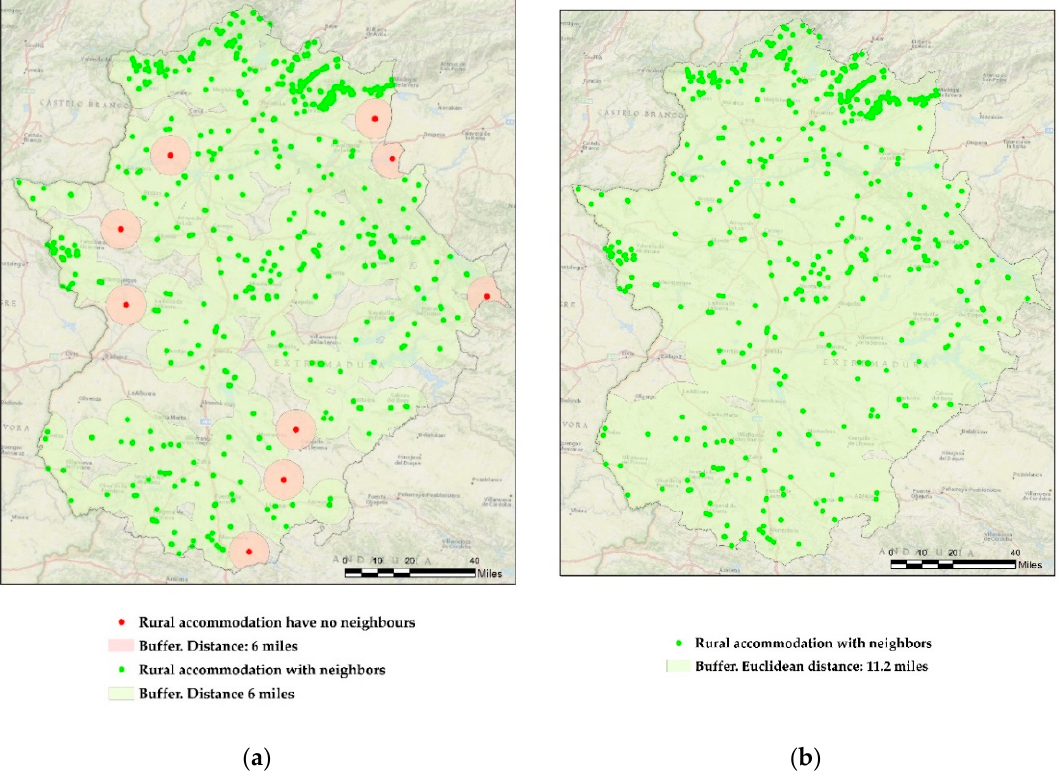
Figure 3. Optimal distance for the calculations. Euclidean distance: 6 miles ( a ); Euclidean distance: 11.2 miles ( b ).